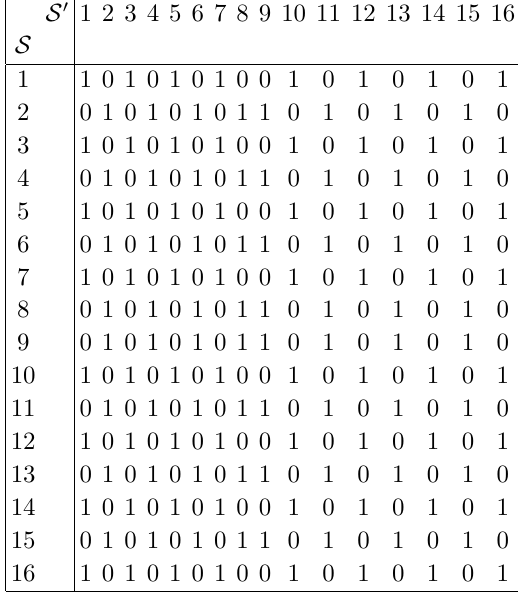
(cid:2) P with di(cid:11)erent boolean factors. [1] [1]